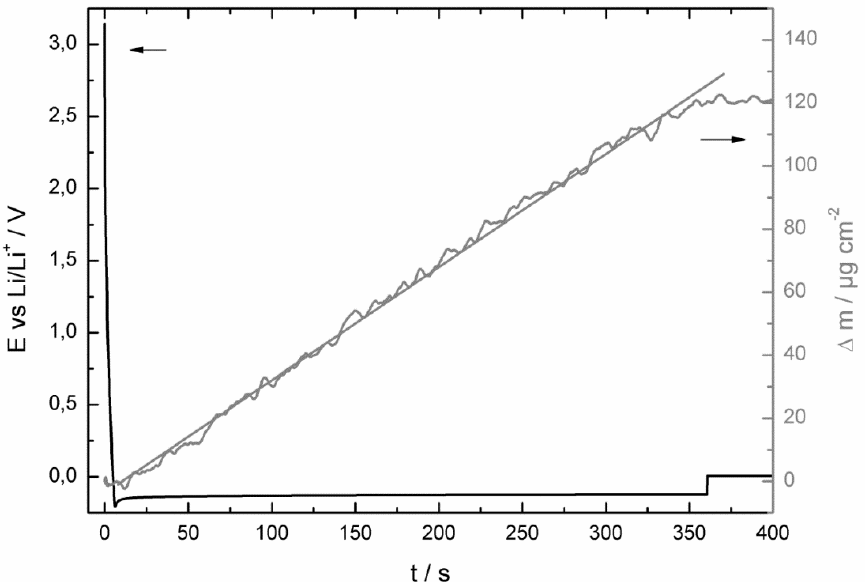
Figure 3. Time dependence of potential and attributed mass change during the chronopotentiometric deposition of lithium on the copper foil on quartz in 1 M LiDFOB in ECDEC (3:7, by wt.).